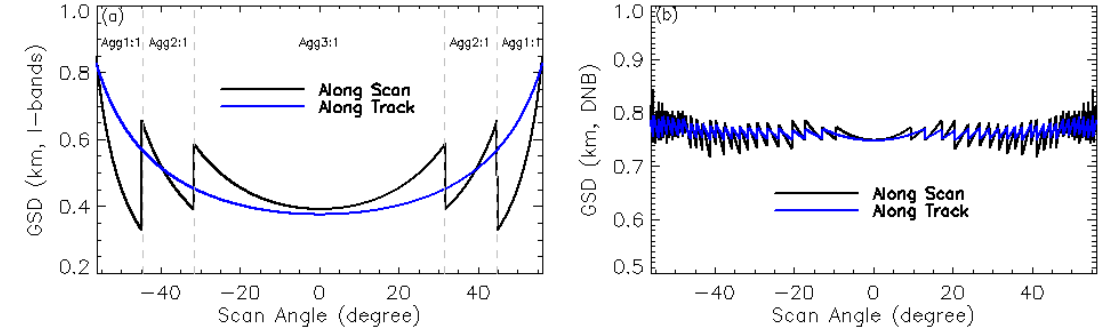
Figure 1. S-NPP VIIRS ground sample distances (GSD) in the along scan and along track directions for ( a ) I-bands; ( b ) Day-Night-Band (DNB).